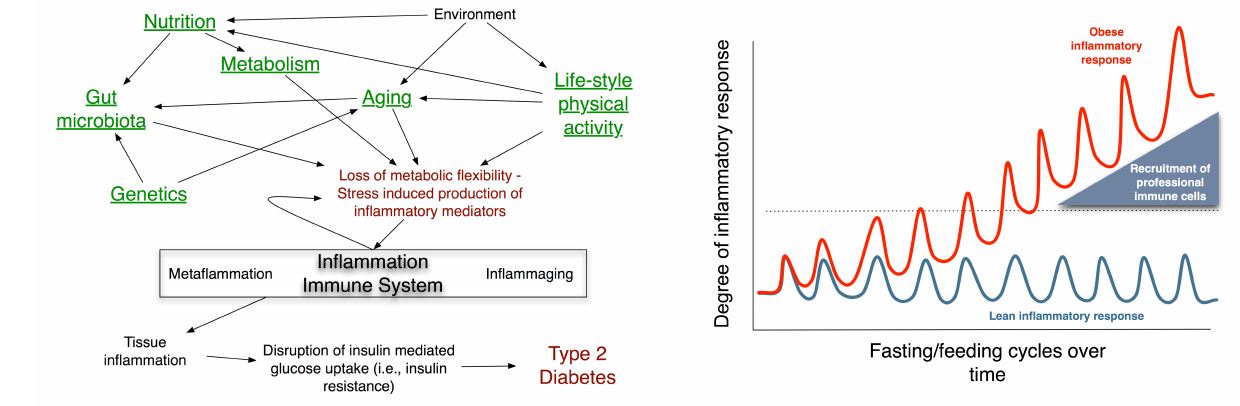
Figure 3. Left: Relationships between the concepts to be modeled in MISSION-T2D: Each aspect will be taken into account either through empirical data or via modeling, with submodels built up into a single integrated model. This will take as input information from genetics, nutrition, age, physical activity habits, and gut microbiota to elaborate a patient-specific risk assessment for the onset of T2D. Right: The pulsatile inflammatory response during feeding, showing differences between the responses of normal and obese individuals’reactions over time: Fasting/feeding cycles induce low-level inflammatory responses in the metabolic cells of average-weight, healthy individuals that are easily resolved. During the high-fat diet or excess feeding that results in obesity, responses to food become more intense and frequent, and the resolution of the inflammatory response becomes less efficient, raising the baseline level of inflammation in metabolic tissues. Once the level of inflammatory response reaches a certain threshold in the metabolic cells, professional immune cells are recruited and activated. The participation of these cells in the inflammatory response alters the tissue environment toward a proinflammatory milieu and exacerbates the inflammation even further